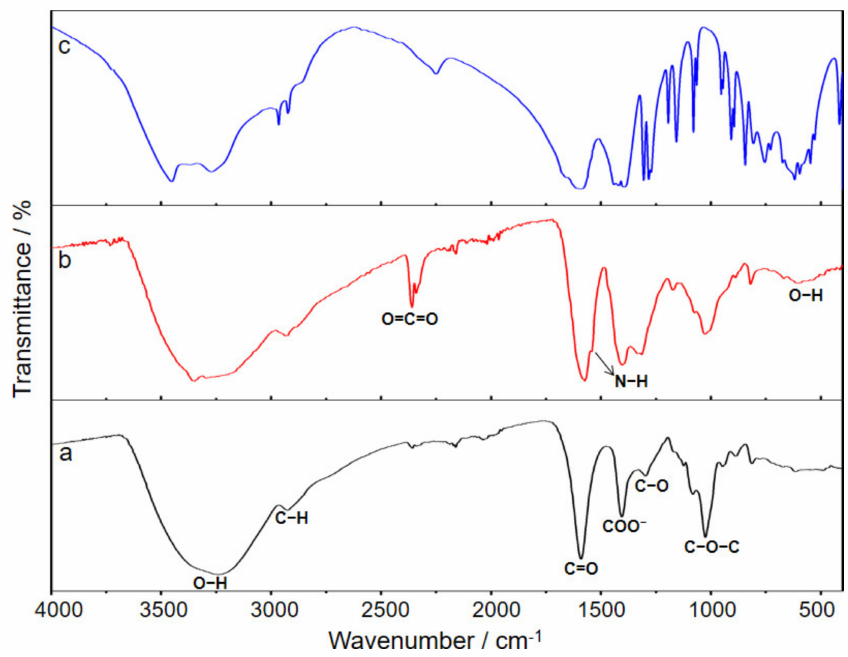
Figure 1. Infrared spectra of ( a ) sodium alginate, ( b ) CA–SC, and ( c ) sodium